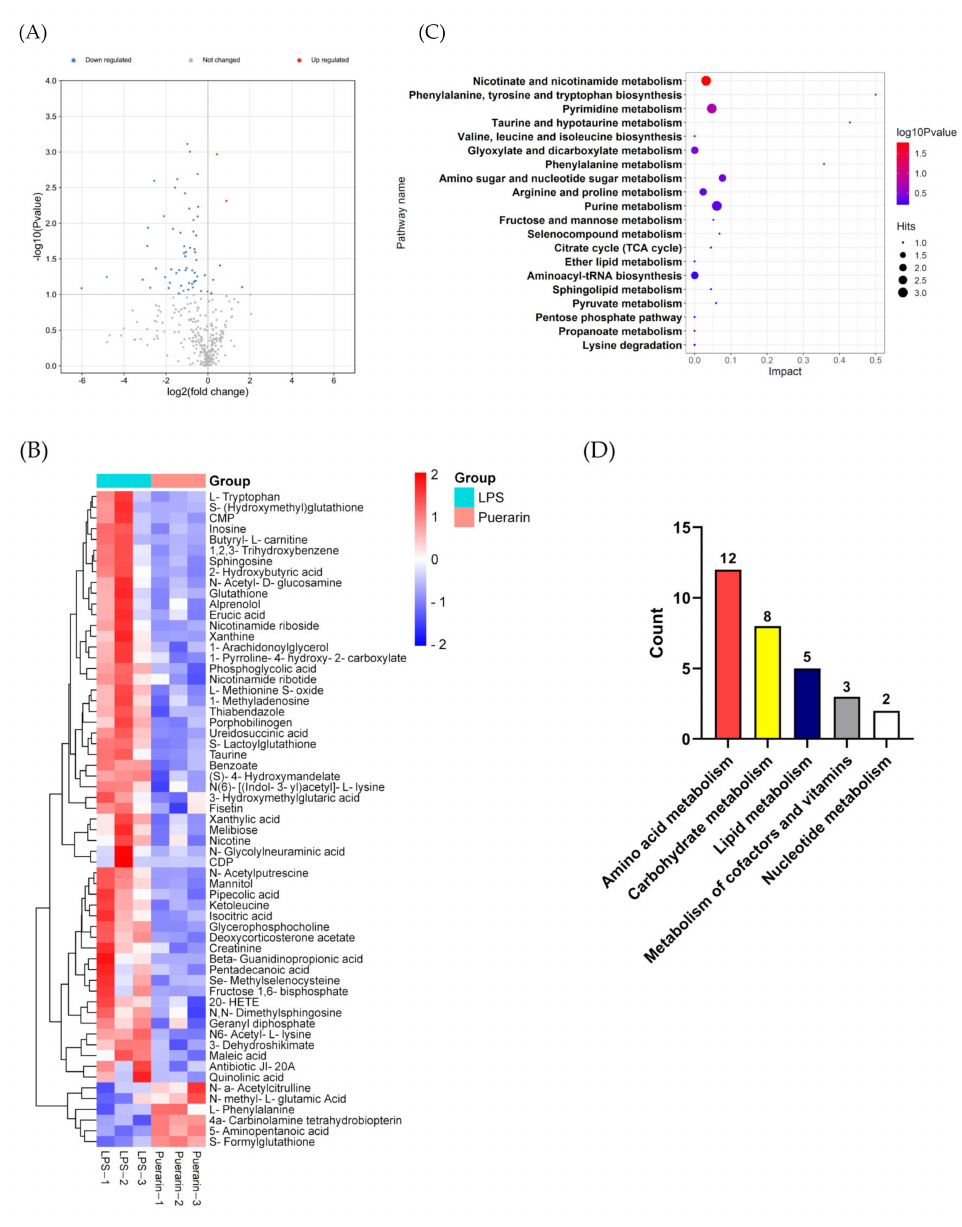
Figure 3. The Metabonomic analysis of puerarin anti-inflammatory. ( A ) Volcano figures and ( B ) heatmap of differential metabolites between the puerarin group and the LPS group. ( C ) Bubble diagram of the top20 KEGG pathways. ( D ) The number of KEGG pathways in each